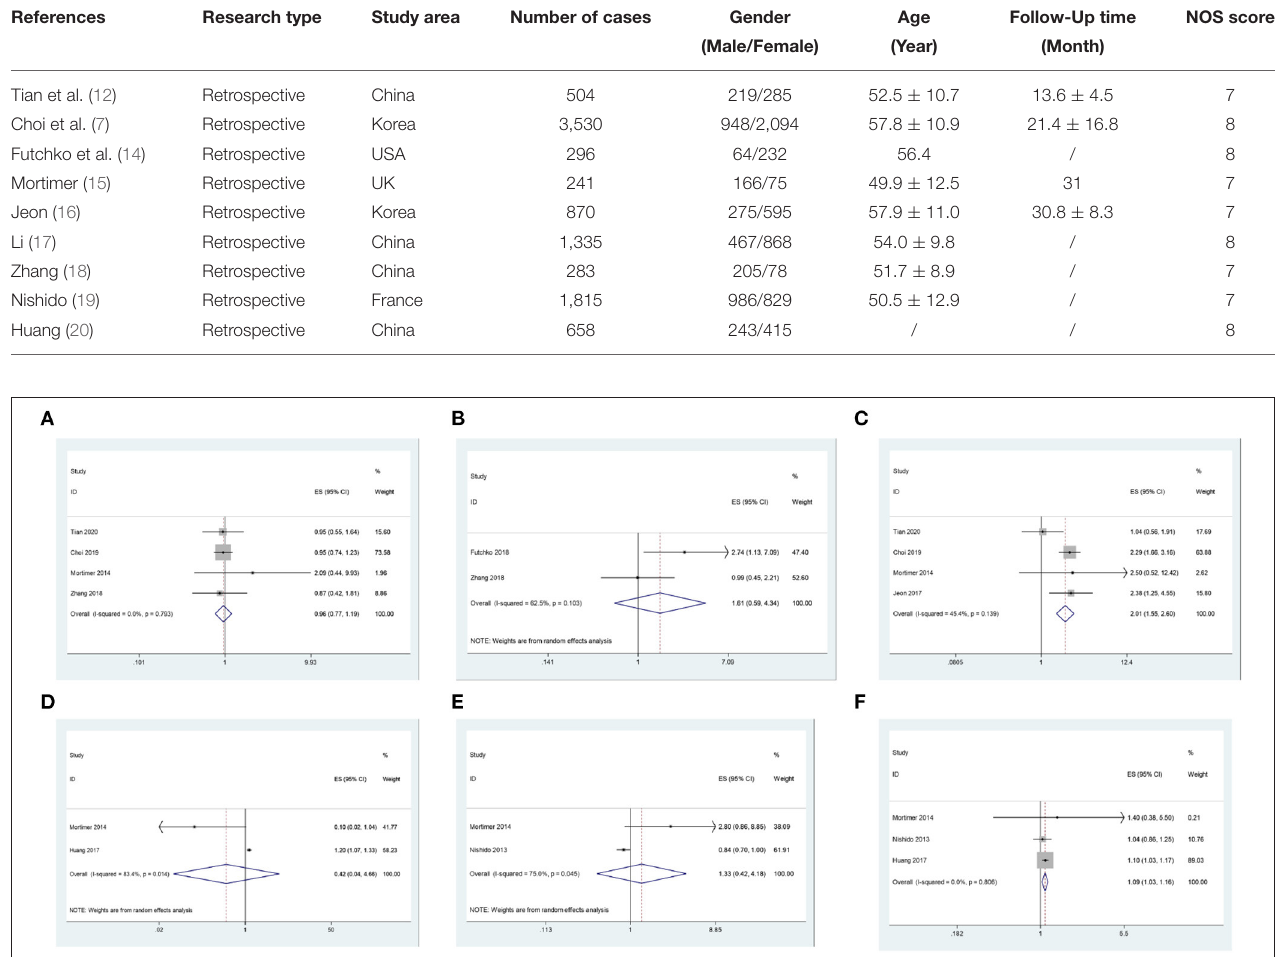
FIGURE 2 | (A) The correlation between gender and recurrence after coil embolization for intracranial aneurysms. (B) The correlation between smoking and recurrence after coil embolization for intracranial aneurysms. (C) The correlation between posterior circulation and recurrence after coil embolization for intracranial aneurysms. (D) The correlation between ACA and recurrence after coil embolization for intracranial aneurysms. (E) The correlation between ICA and recurrence after coil embolization for intracranial aneurysms. (F) The correlation between MCA and recurrence after coil embolization for intracranial